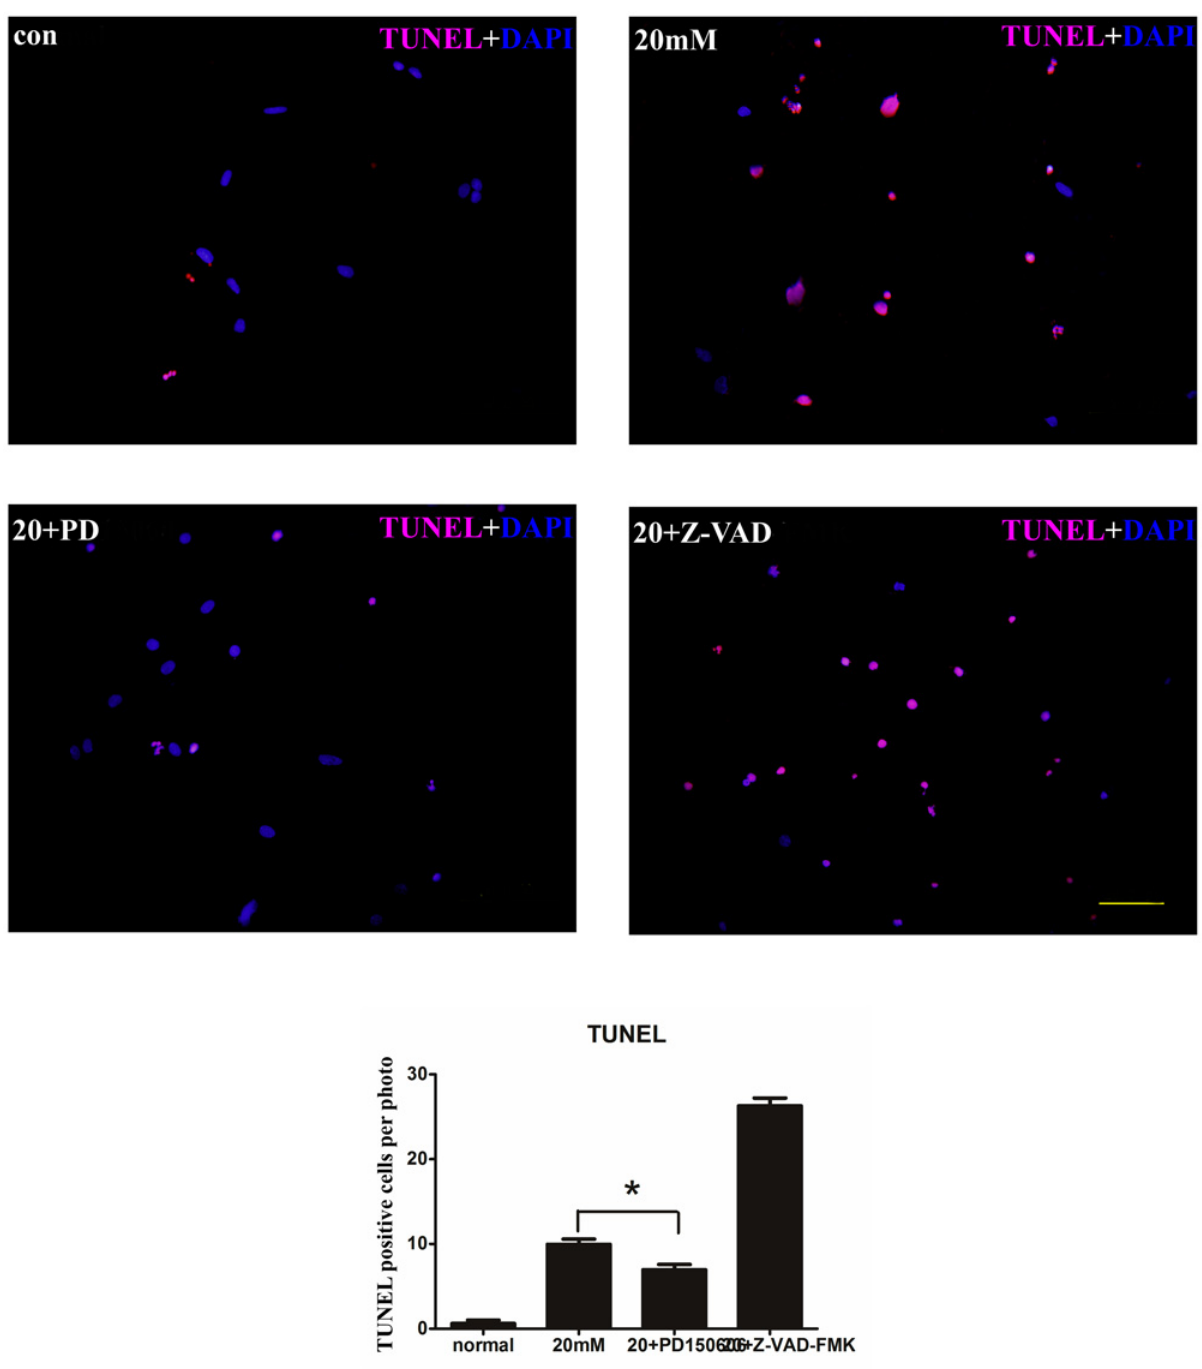
Fig 2. TUNEL staining of SGNs in different interventions. TUNEL staining in cultured SGNs. Red overlapped with the blue nuclei indicates a positive cell. (A) The cells in the normal condition. (B) The cells that were treated with 20 mM Glu. (C) The cells that were treated with 20 mM Glu and PD150606. (D) The cells that were treated with 20 mM Glu and Z-VAD-FMK. Photos were taken under the fluorescence microscope. Scale bar = 50 μ m. Positive cells were counted in each photo and a histogram was drawn. The cell count for 20 mM Glu+PD150606-treated group was lower compared with 20 mM Glu-treated group (P <